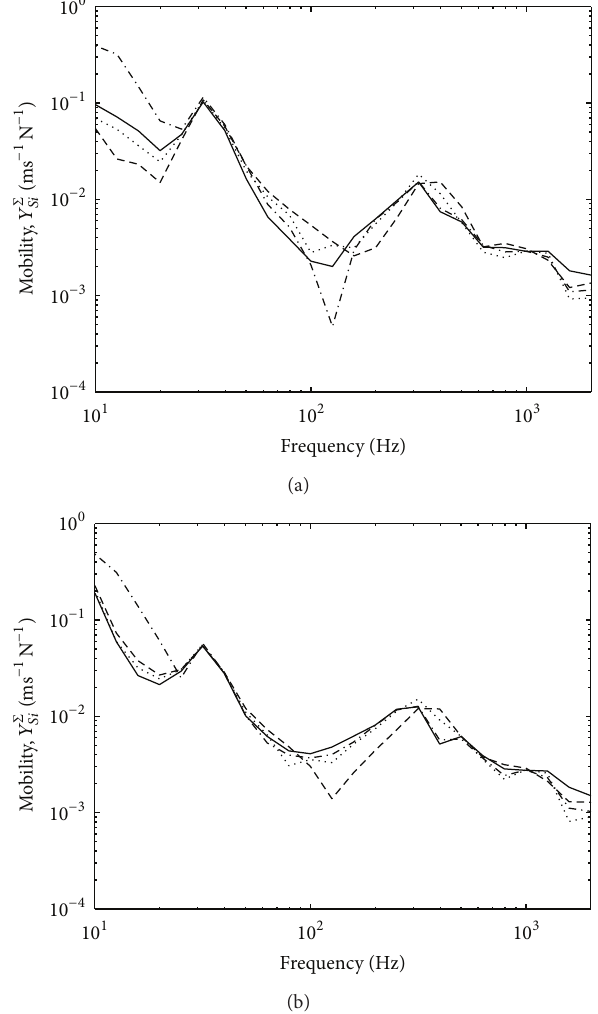
Figure 12: Effective mobility of source by assuming (a) zero phase and (b) random